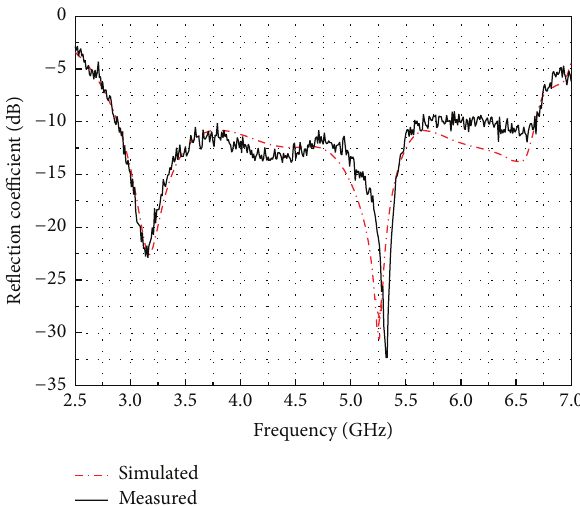
Figure 10: Measured and simulated reflection coefficient of the proposed